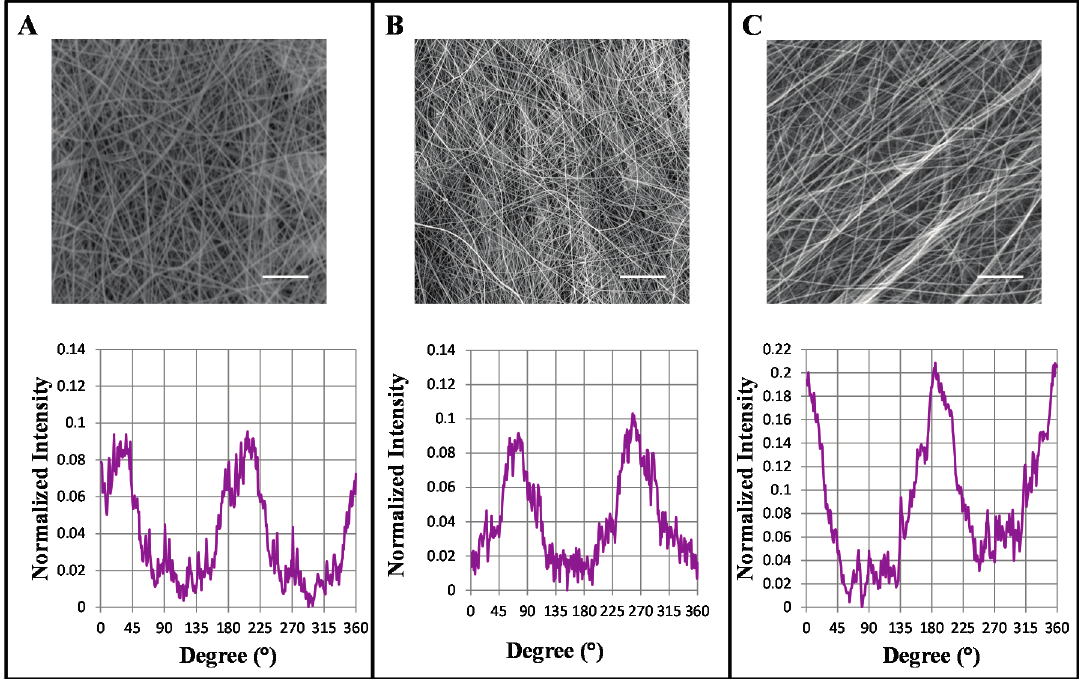
Figure 1. Scanning electron microscopy (SEM) micrographs and 2D fast fourier transform (FTT) analysis of nano-fibers collected using rotating mandrel rates of 300 ( A ), 1200 ( B ) and 2400 ( C ) rpm. Scale bars: 10